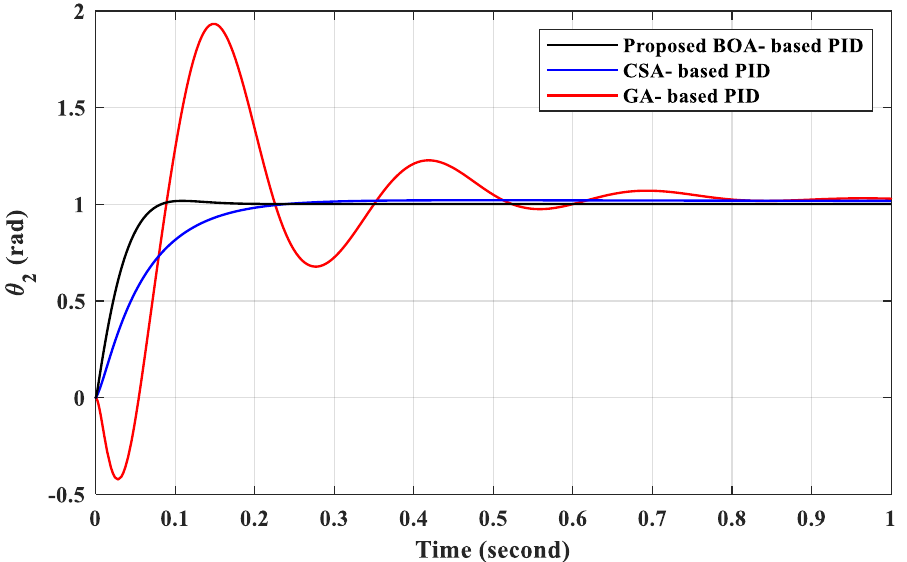
Figure 6. The output response of link2 in the case of Scenario 1.